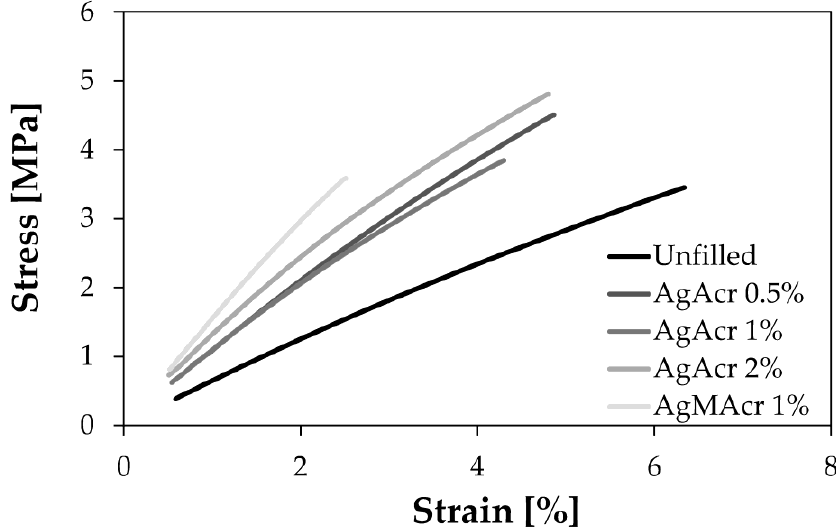
Figure 5. Representative stress-strain diagram for Ag-filled and unfilled samples. Table 1. Tensile properties of 3D printed specimens ( E t : Young’s modulus; σ M : tensile strength; ε B : tensile strain at break, according to ISO 527 technical